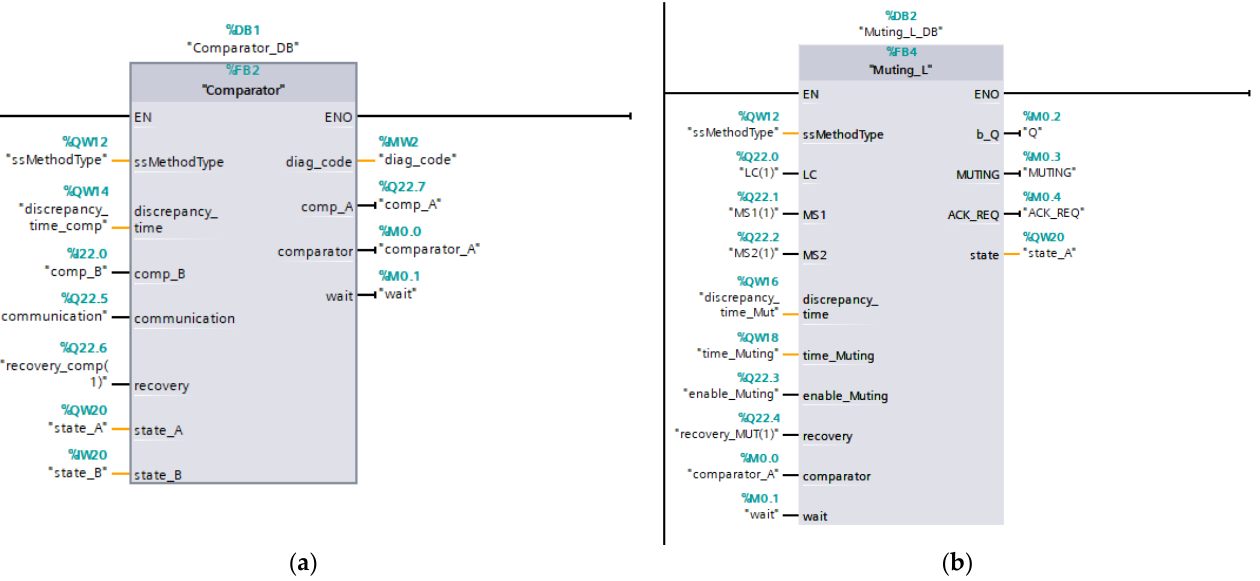
Figure 8. Function block of the comparator ( a ) and function block of the “Muting” safety function ( b ). For sPLC A and sPLC B to work together, communication between them is